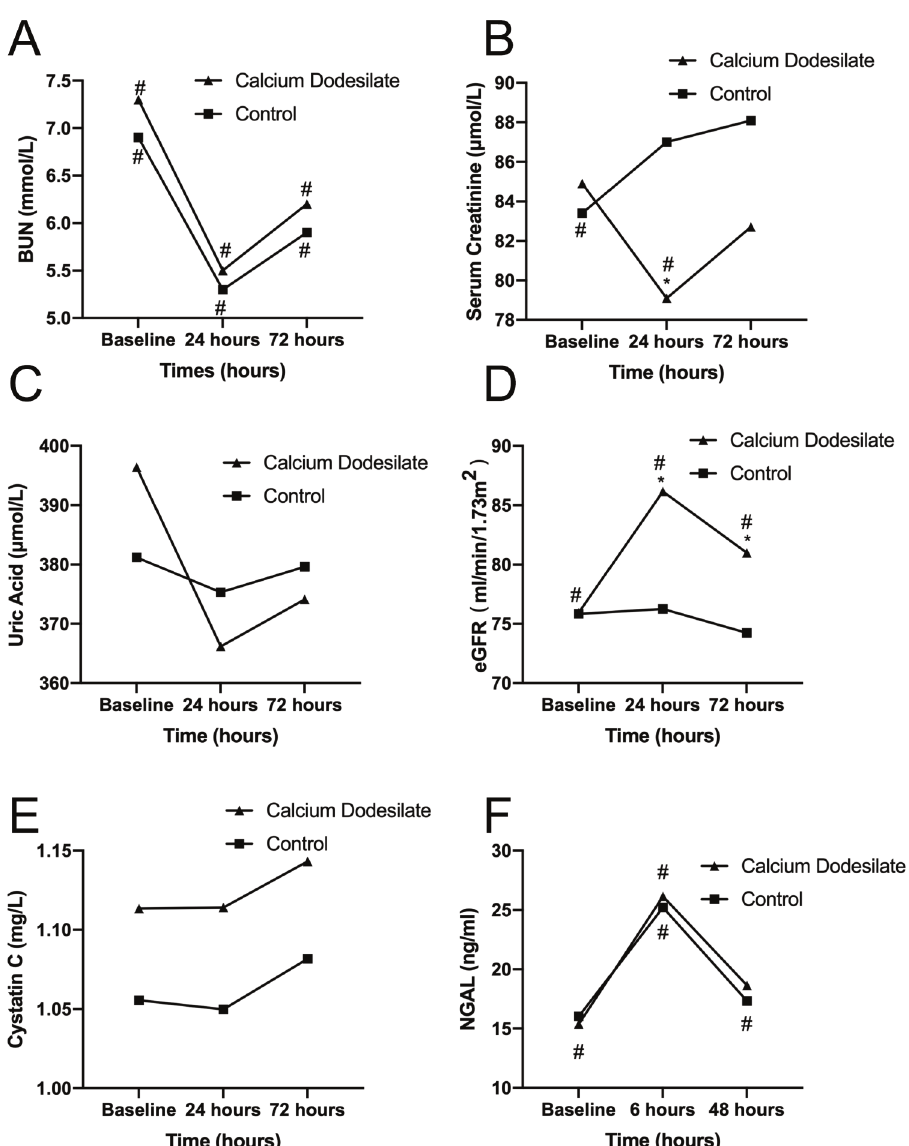
Figure 2 - The Comparison of the blood urea nitrogen (A), serum creatinine (B), uric acid (C), eGFR (D), Cystatin C (E), and NGAL (F) levels between the experimental (calcium dobesilate receiving) and control groups. Abbreviations: BUN, blood urea nitrogen; eGFR, estimated glomerular filtration rate; NGAL, neutrophil gelatinase-associated lipocalin * p o 0.05, compared with the control group, # p o 0.05, compared with the other two measurement time points in the same